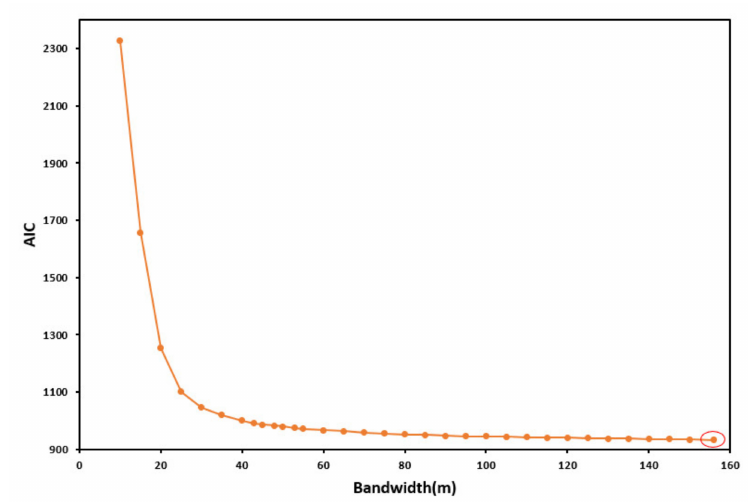
Figure 5. Selection of optimal bandwidth for the GWR model.